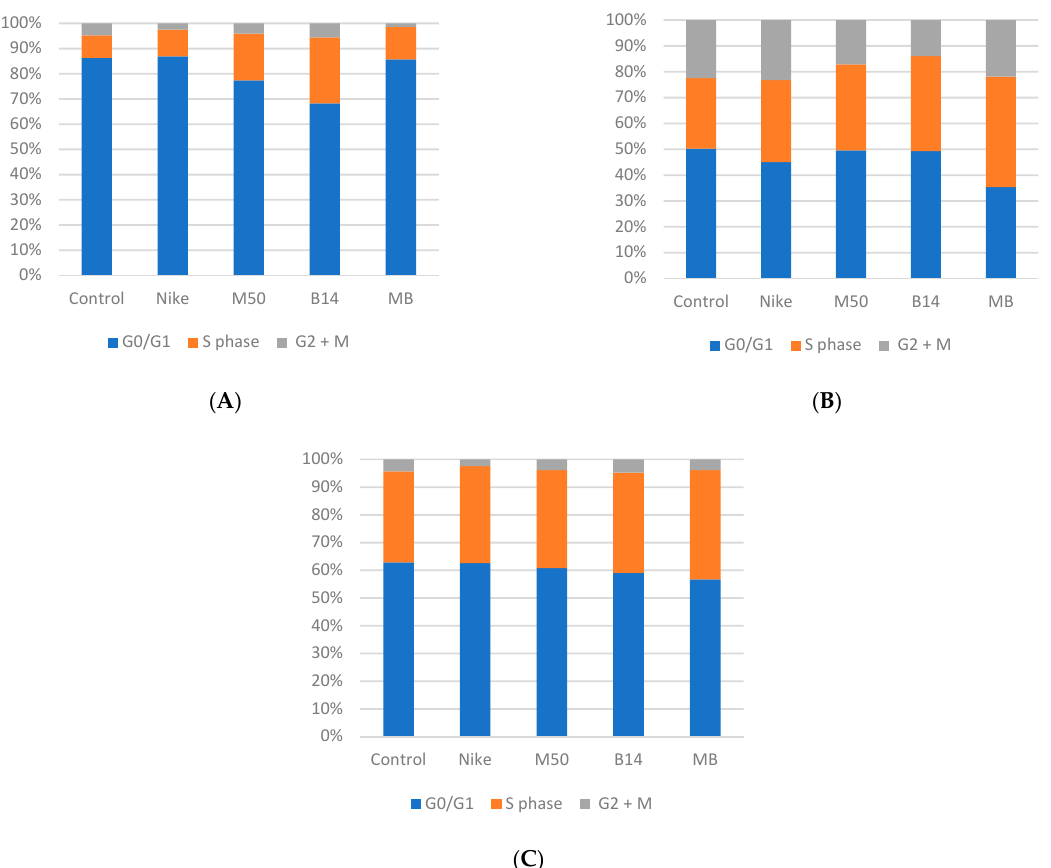
Figure 6. The cell cycle in HEMVEC ( A ), NHEK ( B ) and THP-1 ( C ) cells after 48 h incubation.